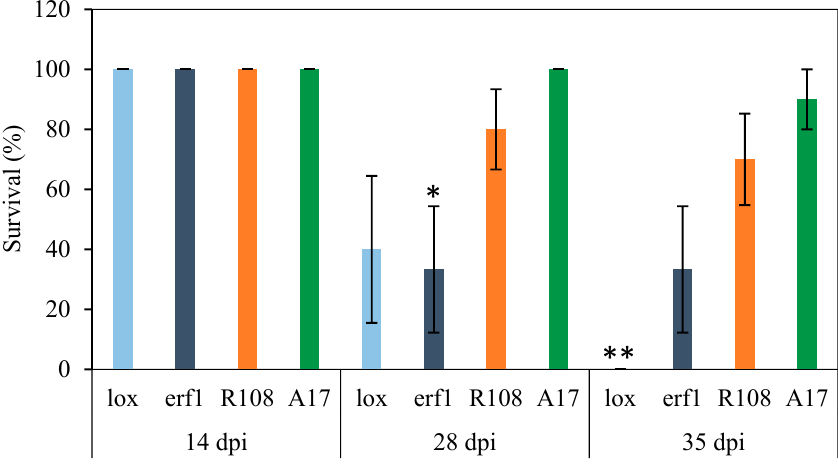
Figure 2. Susceptibility of JA-related Tnt1 -insertion mutants to F. oxysporum . Seedlings were inoculated with F. oxysporum ( Fom -5190a) and survival rates monitored over 35-days. Values are averages ± SE (n = 10). The Tnt1 -insertion mutants are in the R108 background and their details noted in Table 2. A17 is included as a resistant control. Asterisks indicate values that are significantly different (** p < 0.01, * p < 0.05, Student’s t-test) from R108. Similar results were obtained in an